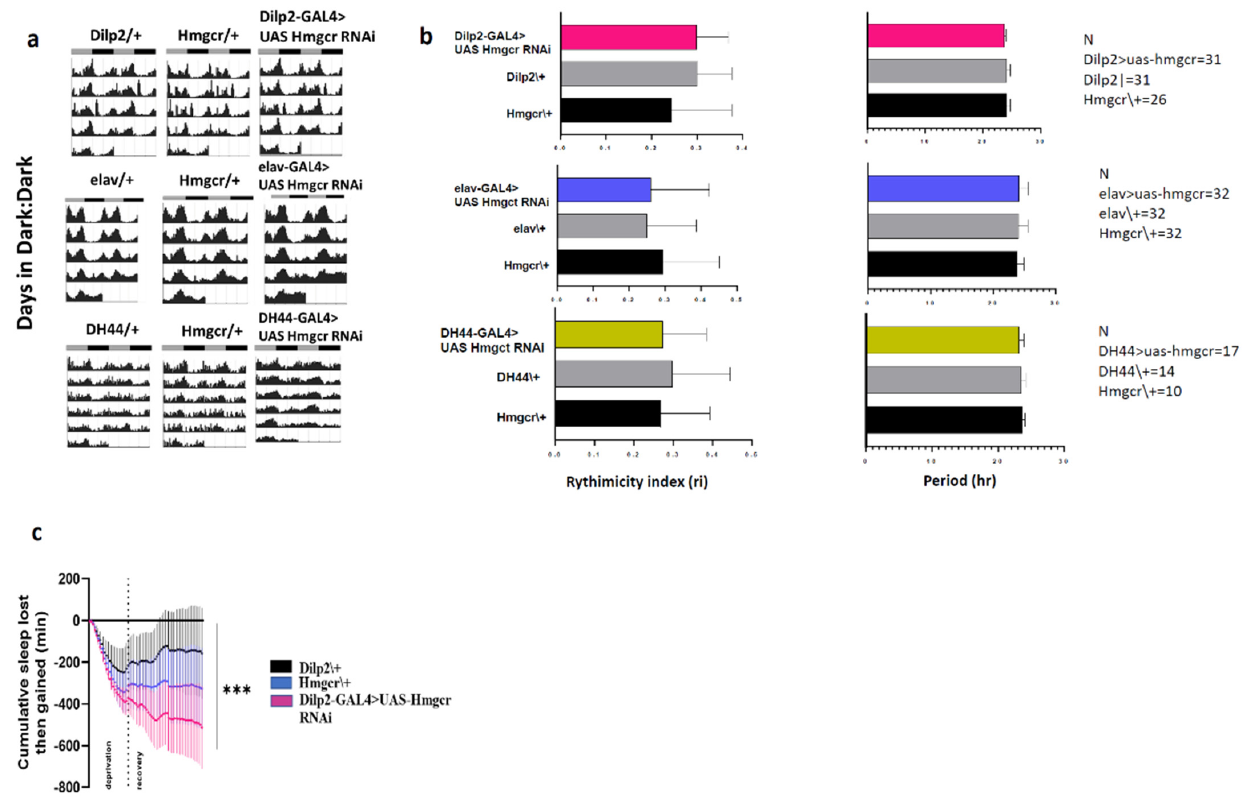
Figure 6. Hmgcr activity in the IPCs is not required for circadian rhythm ( a ) Double plotted actogram for 5 days in dark:dark (DD) constant condition. ( b ) Average rhythmicity index and free-running period. Results with error bars are mean ± S.D. One ‐ way ANOVA was performed, n = 30, male flies. ( c ) Sleep deprivation occurred after three baseline days at normal light: dark condition, by switching on the light for 12 h overnight. The regained sleep was measured over the following 24 hr. The sleep rebound response was significantly lowered in the Hmgcr knockdown flies ( Dilp2 ‐ GAL4 > UAS ‐ Hmgcr RNAi) in the PI compared to the controls ( Dilp2 ‐ GAL4 > w 1118 and w 1118 > UAS ‐ Hmgcr RNAi). The results with errors bars are mean ± S.D. n = 32 for each group, male flies. To detect the significant difference between groups a Shapiro–Wilk test was performed to determine normal ‐ ity, then a one ‐ way ANOVA and Bonferroni post hoc test was performed to detect significant gen ‐ otype effects. p ‐ values = *** 0.0001. 3. Discussion Statins are a widely used medication to prolong survival and prevent the conse ‐ quences of cardiovascular diseases. However, many people reported statins might cause sleep disturbances, including insomnia. Clinical considerations underscore an urgency to identify a firm conclusion on whether statins affect patients’ sleep regulation, as statins discontinuation or non ‐ adherence rates are increasing due to these unsubstantiated side effects [ 27]. In fact, recent studies found that low adherence to statin therapy was associ ‐ ated with an increased risk of death [28,29]. Statins are among the most effective medica ‐ tions for the prevention of CVDs; therefore, understanding the reasons for low adherence might give clinicians new strategies for increasing patient compliance. Therefore, we per ‐ formed our study to understand if statins, and their target Hmgcr, can contribute to sleep disturbances. This is the first study showing that Hmgcr activity is important in the regulation of sleep. Both pan ‐ neuronal Hmgcr knockdown and fluvastatin treatment modulate sleep parameters in a similar pattern, suggesting neurons that regulate sleep need Hmgcr